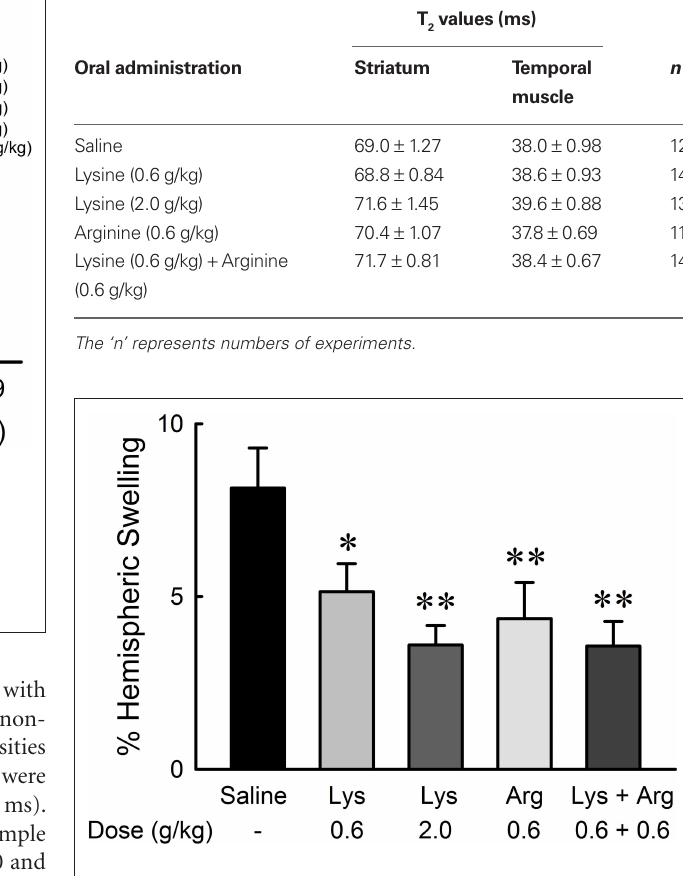
Table 1 | T values in non-ischemic striatum and temporal muscle. 2